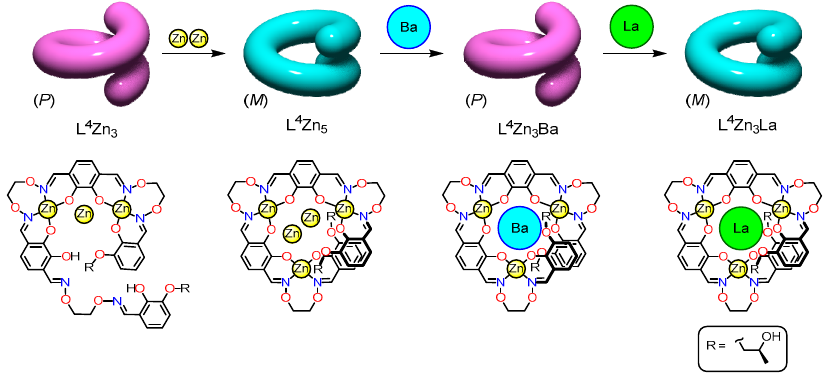
Figure 13. Three ‐ step conversion among metal complexes, L 4 Zn 3 , L 4 Zn 5 , L 4 Zn 3 Ba, and L 4 Zn 3 La, associated with sequential helicity inversion.